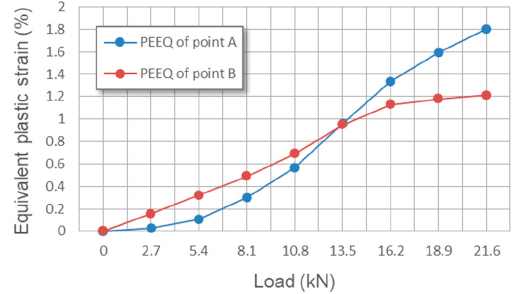
Figure 21. Variations of the equivalent plastic strains at points A and B of Ti-(SiC f /Al 3 Ti) with different loads.